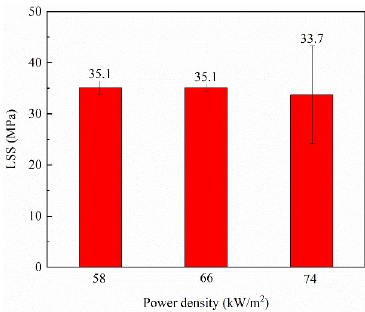
Figure 8. LSS of welded samples obtained with type B heating element at different power densities .